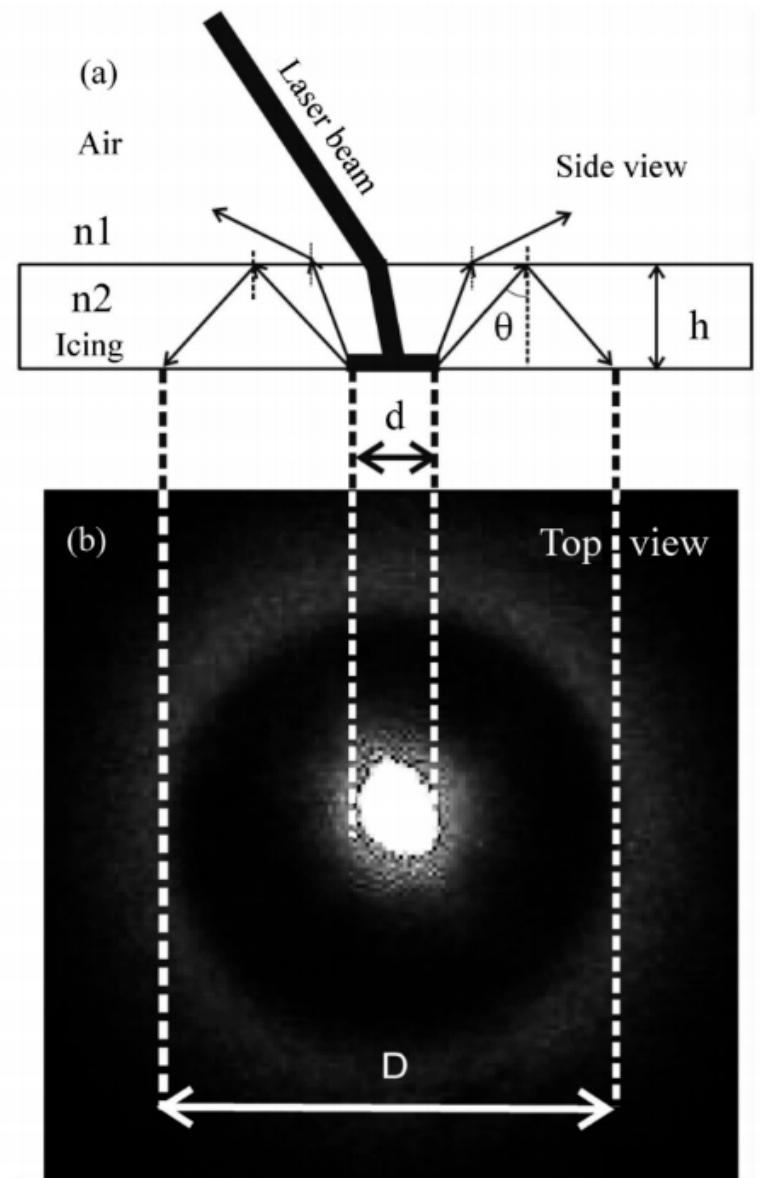
Figure 4. The principle of the total internal reflection method. ( a ) The beam path in the icing layer above the light scattering surface is shown. ( b ) As a result of refraction and reflection at the interface, an image shaped like a circle appears.